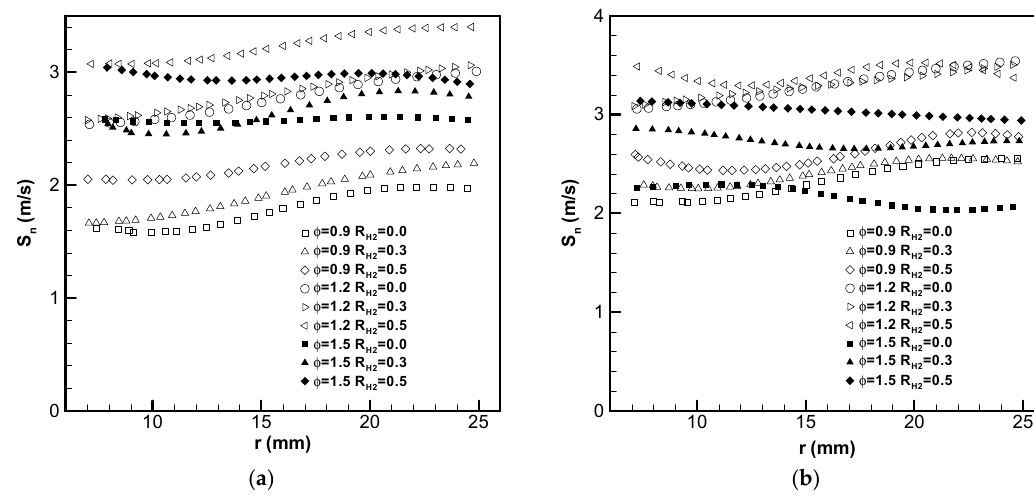
S versus flame radius. ( a ) T = 390 K; ( b ) T = 420 K. n